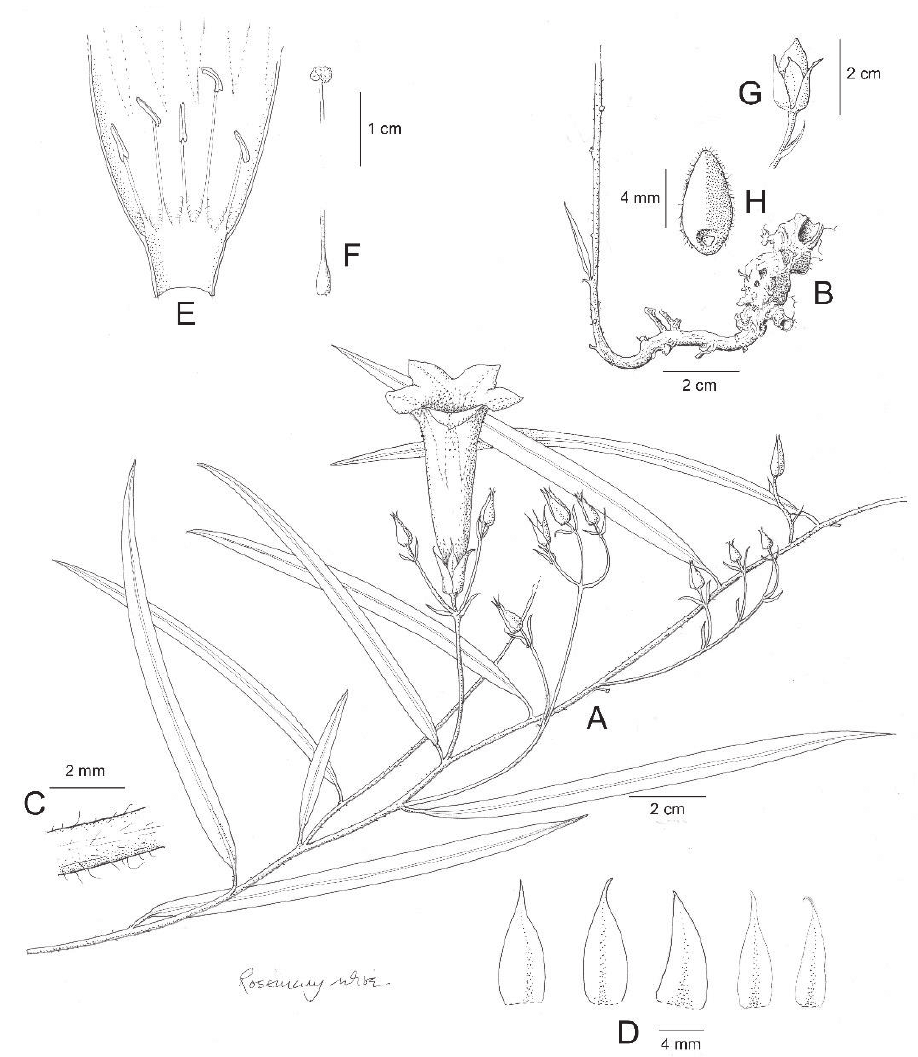
Figure 1. Ipomoea attenuata A habit B xylopodium C section of stem showing indumentum D sepals outermost (left) to innermost (right) e corolla opened out to show stamens F ovary and style G capsule h seed. Drawn by Rosemary Wise A–e from H.S. Irwin et al. 11019 F–h from M. Mendoza et al.